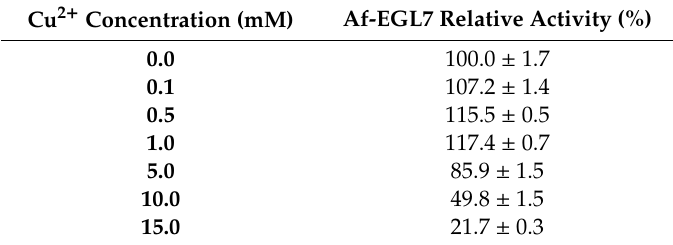
Table 2. E ff ect of di ff erent Cu 2 + concentrations on Af-EGL7